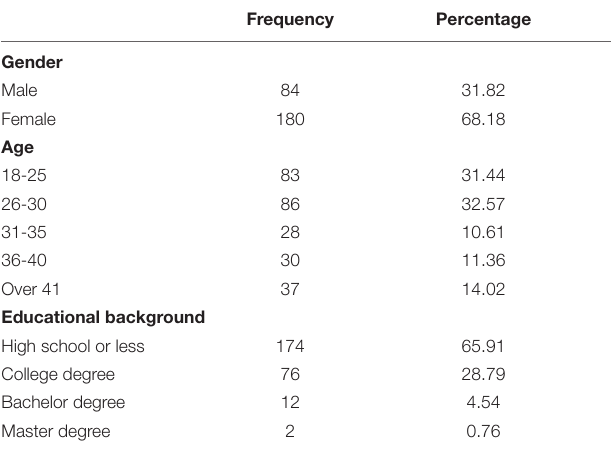
TABLE 2 | Demographic profile of the respondents